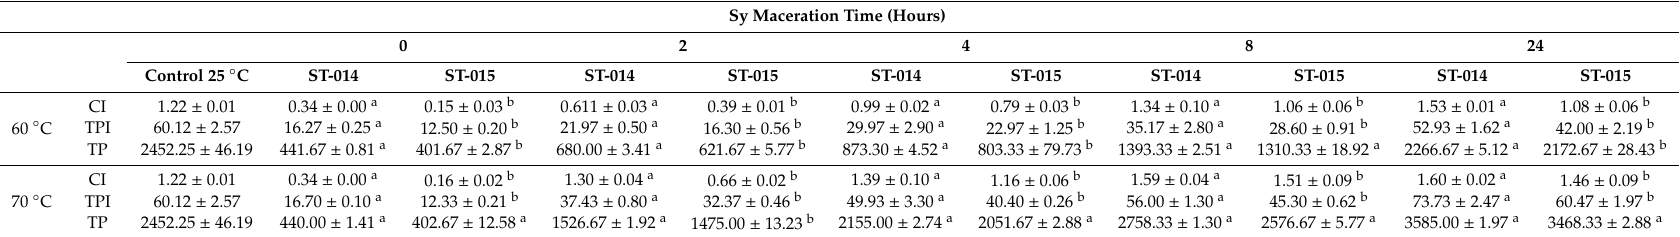
Table 2. Total polyphenol, total polyphenol index and color intensity of the Syrah Saint Thomas musts for the two consecutive years (2014 and 2015) and the 2014 grape harvest year of the Syrah Saint Thomas control (25 ◦ C) in terms of time and